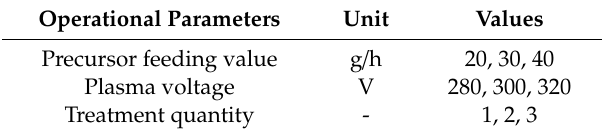
Figure 1. Schematic view of the atmospheric pressure plasma system ( a ) and the real image of the process of atmospheric pressure plasma treatment ( b ). Table 1. Operational parameters considered in plasma treatment process.